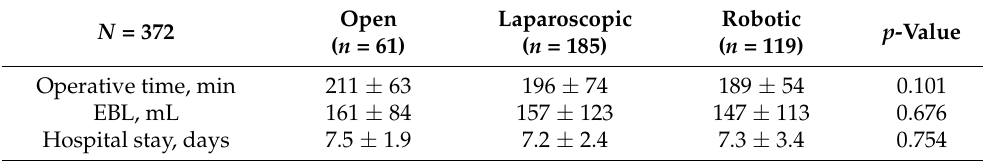
Table 2. Hospital course and complications within 90 days after